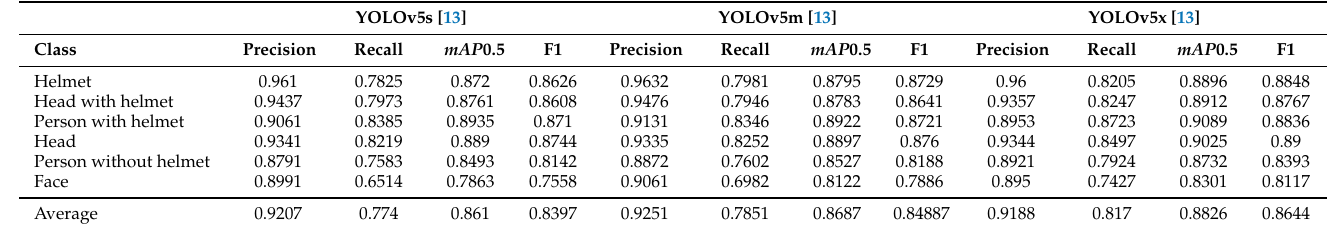
Table 4. Comparison results of different variations of YOLOv5-P5 [13]: (a) YOLOv5s, (b) YOLOv5m, and (c)